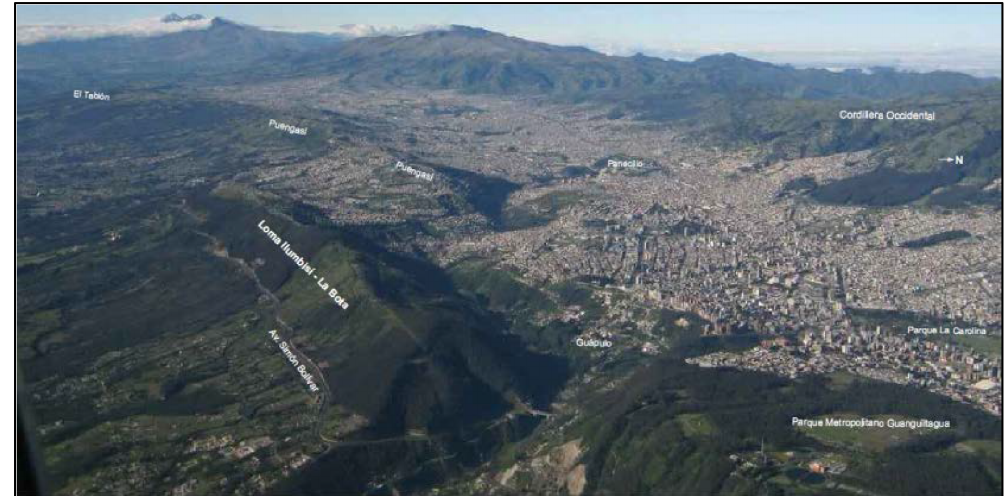
Figure 3. The Ilumbisi-La Bota hill at the front, and the Puengasí hill at the rear.